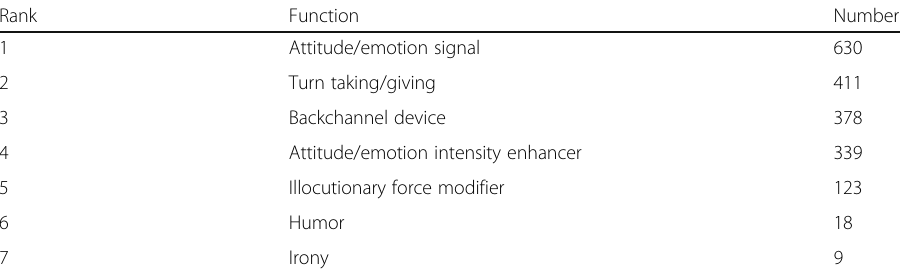
Table 1 Function ranking of